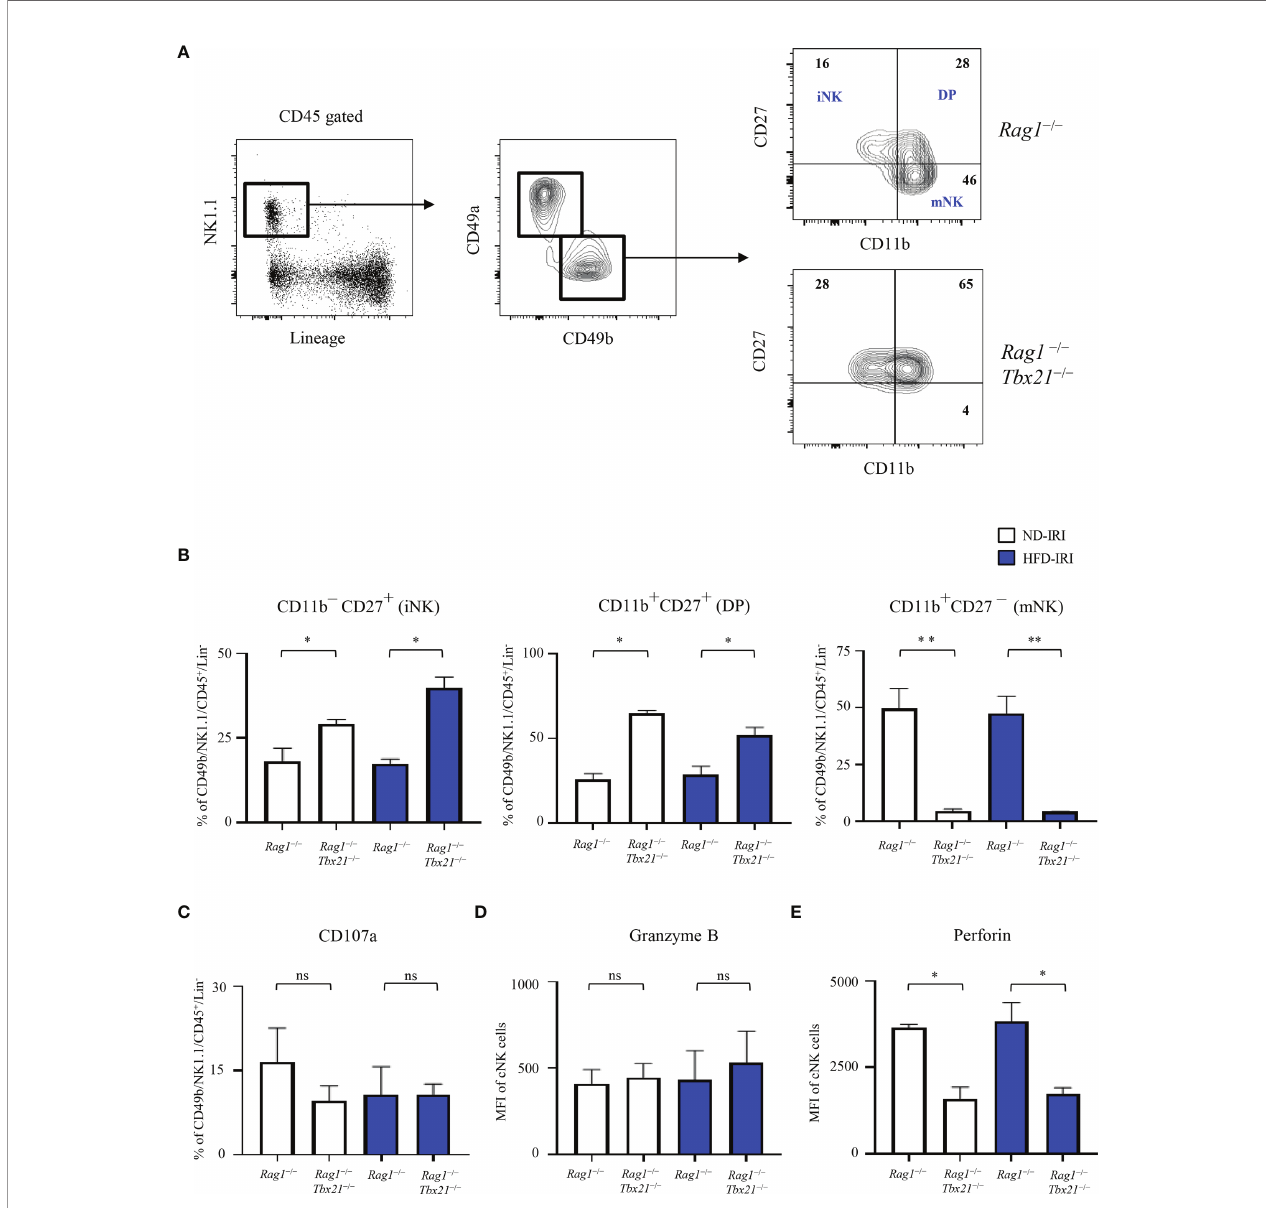
FIGURE 5 | Lack of T-bet leads to a decrease in mNK cells and lower expression of perforin. (A) Gating strategy of cNKs from the hepatic lymphocytes: lineage- negative (Lin - ) NK1.1 + cells expressing CD45 were identi fi ed as cNKs by expression of CD49a and CD49b. Immature NK (CD11b − CD27 + ), Double Positive (CD11b + CD27 + , DP) and mature NK (CD11b + CD27 − ) were identi fi ed by CD11b and CD27 expression, as shown. Representative fl ow plots (A) from ND-IRI Rag1 − / − compared with ND-IRI Rag1-Tbet DKO mice and bar graph (B) showing NK cell developmental stages in IRI Rag1 − / − compared with IRI Rag1-Tbet DKO mice. n=4 mice per group. (C) The frequency of CD107a staining of cNK cells from ND-IRI and HFD-IRI mice. Fresh hepatic lymphocytes were cultured for 4 h in the presence of anti-CD107a and Brefeldin (A) MFI of granzyme B (D) and perforin (E) staining in cNK cells from ND-IRI and HFD-IRI mice. n=4 mice per group. Signi fi cance was determined using Mann Whitney Test. *p<0.05. **p<0.01; ns, not signi fi